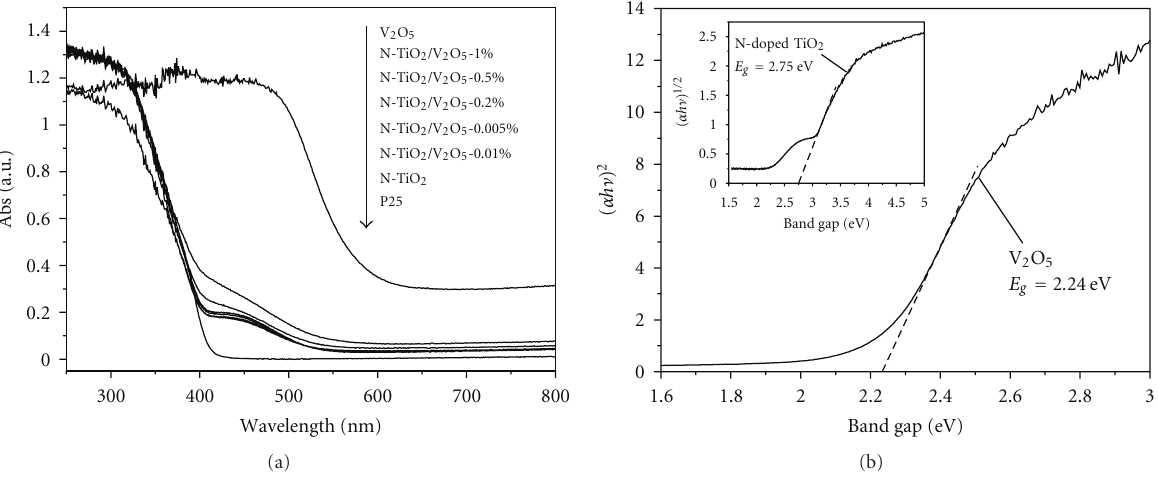
Figure 5: UV-vis DRS of N-doped TiO 2 , N-TiO 2 /V 2 O 5 , V 2 O 5 samples and P25 (a). Plot of ( α h ν ) 2 versus photon energy of V 2 O 5 (direct semiconductor) (b), inset in (b) shows the plot of ( α h ν ) 1 / 2 versus photon energy of N-TiO 2 (indirect